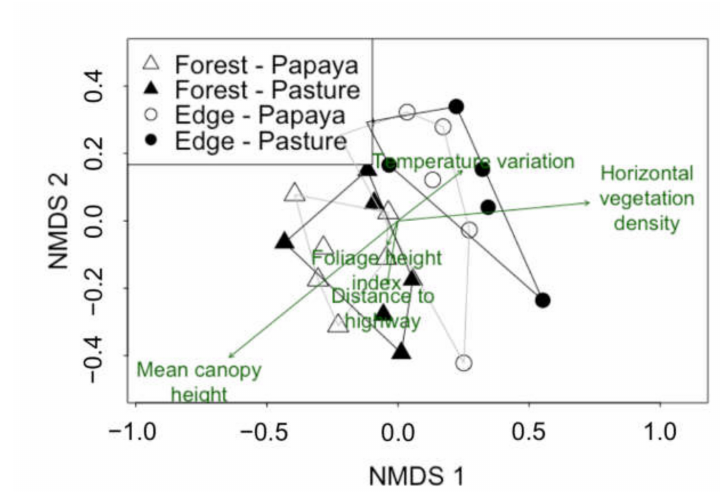
Figure A1. Non-metric multidimensional scaling (NMDS) with ordination based on Bray–Curtis dissimilarities to compare forest interiors and forest edges by site category. Triangles represent forest interiors and circles represent forest edges. Black-filled symbols represent vegetation types at papaya sites and empty symbols represent vegetation types at pasture sites. Vectors represent explanatory variables, including distance to the Interoceanic Highway, and their lengths represent the strengths of their relationship with NMDS axis. We excluded agricultural land from this analysis because vegetation measurements were only made at forest interiors and forest edges.